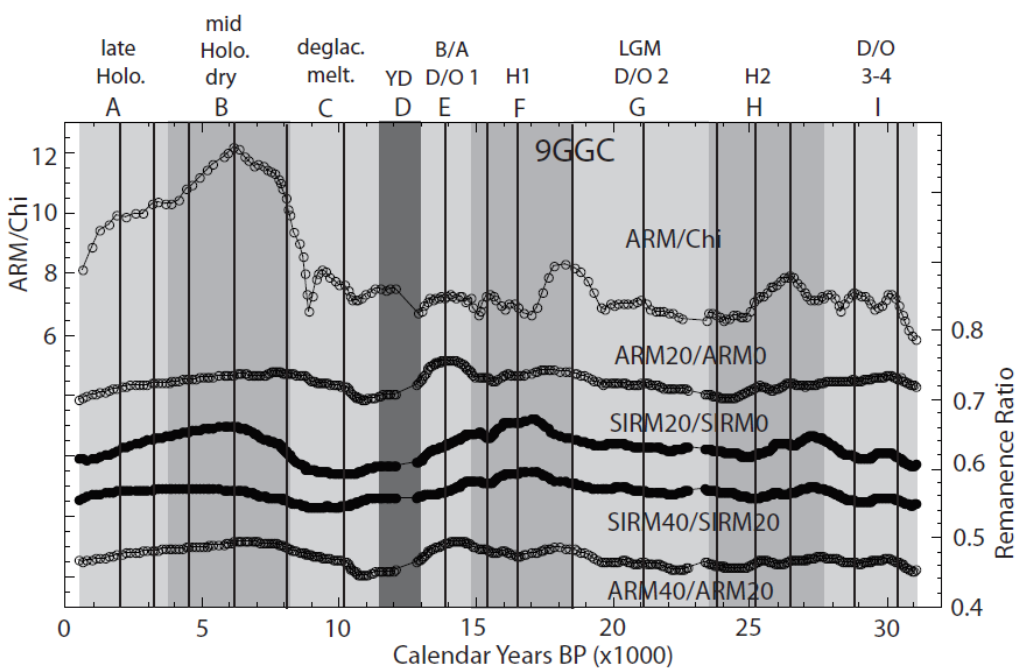
Figure 8. Rock magnetic coercivity variability for core 9GGC versus time. Alternating light and dark grey zones are multi-millennial-scale oscillations in magnetic coercivity (light = lower coercivity or coarser-grained; dark = higher coercivity or finer-grained) labeled A–I. Vertical lines indicate finer-scale millennial intensity peaks noted in Figures 6 and 7. There is no significant evidence for coercivity variations associated with those intensity variations.